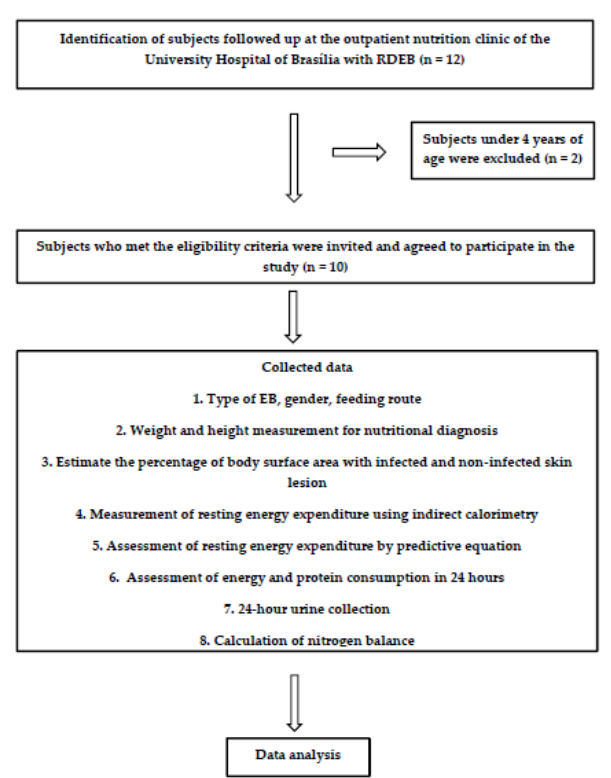
Figure 1. Study procedures. EB: epidermolysis bullosa, RDEB: recessive dystrophic EB.